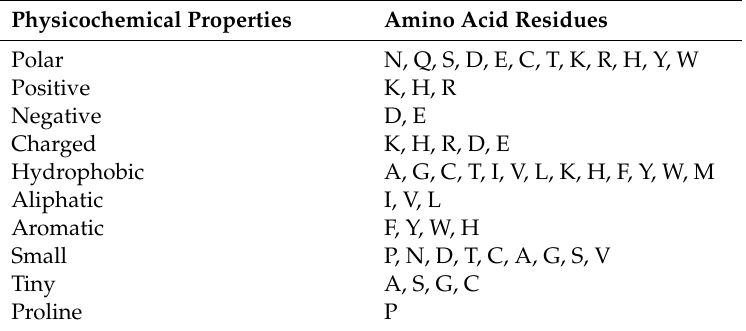
Table 4. Amino acid groups based on Taylor’s overlapping